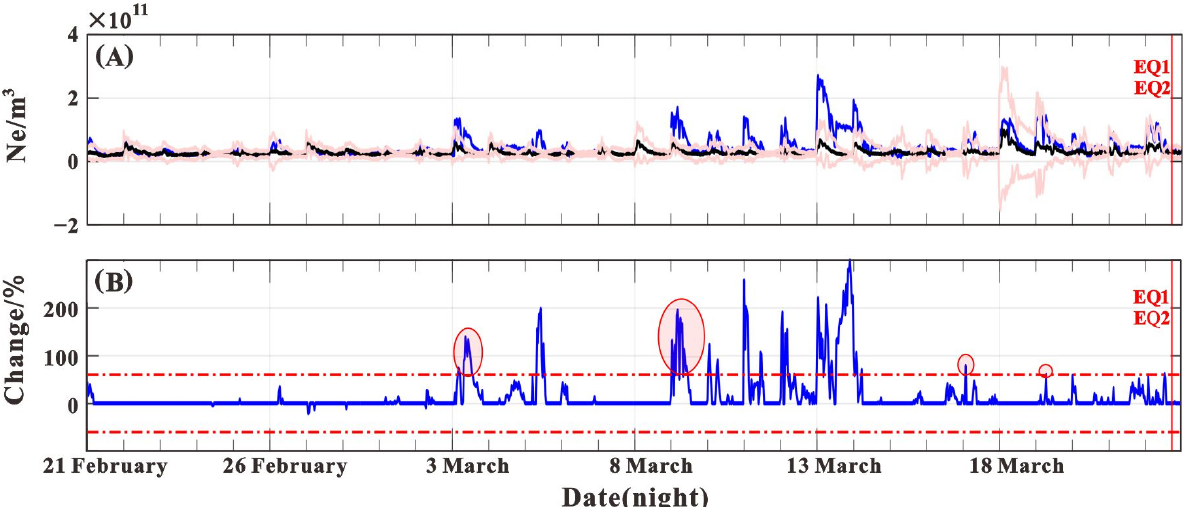
Figure 3. ( A ) Time-series analysis of CSES Ne variations from 21 February to 22 March 2022. The blue line represents the observed Ne value. The black line represents the median value. The pink lines represent the upper and lower boundaries of the IQR ; ( B ) time-series analysis of CSES Ne variations and associated anomalies from 21 February to 22 March 2022. The blue line represents the relative change in Ne, the dotted red lines represent the thresholds (±60%) used to judge whether a Ne anomaly exists, and the red circles mark the Ne anomalies.